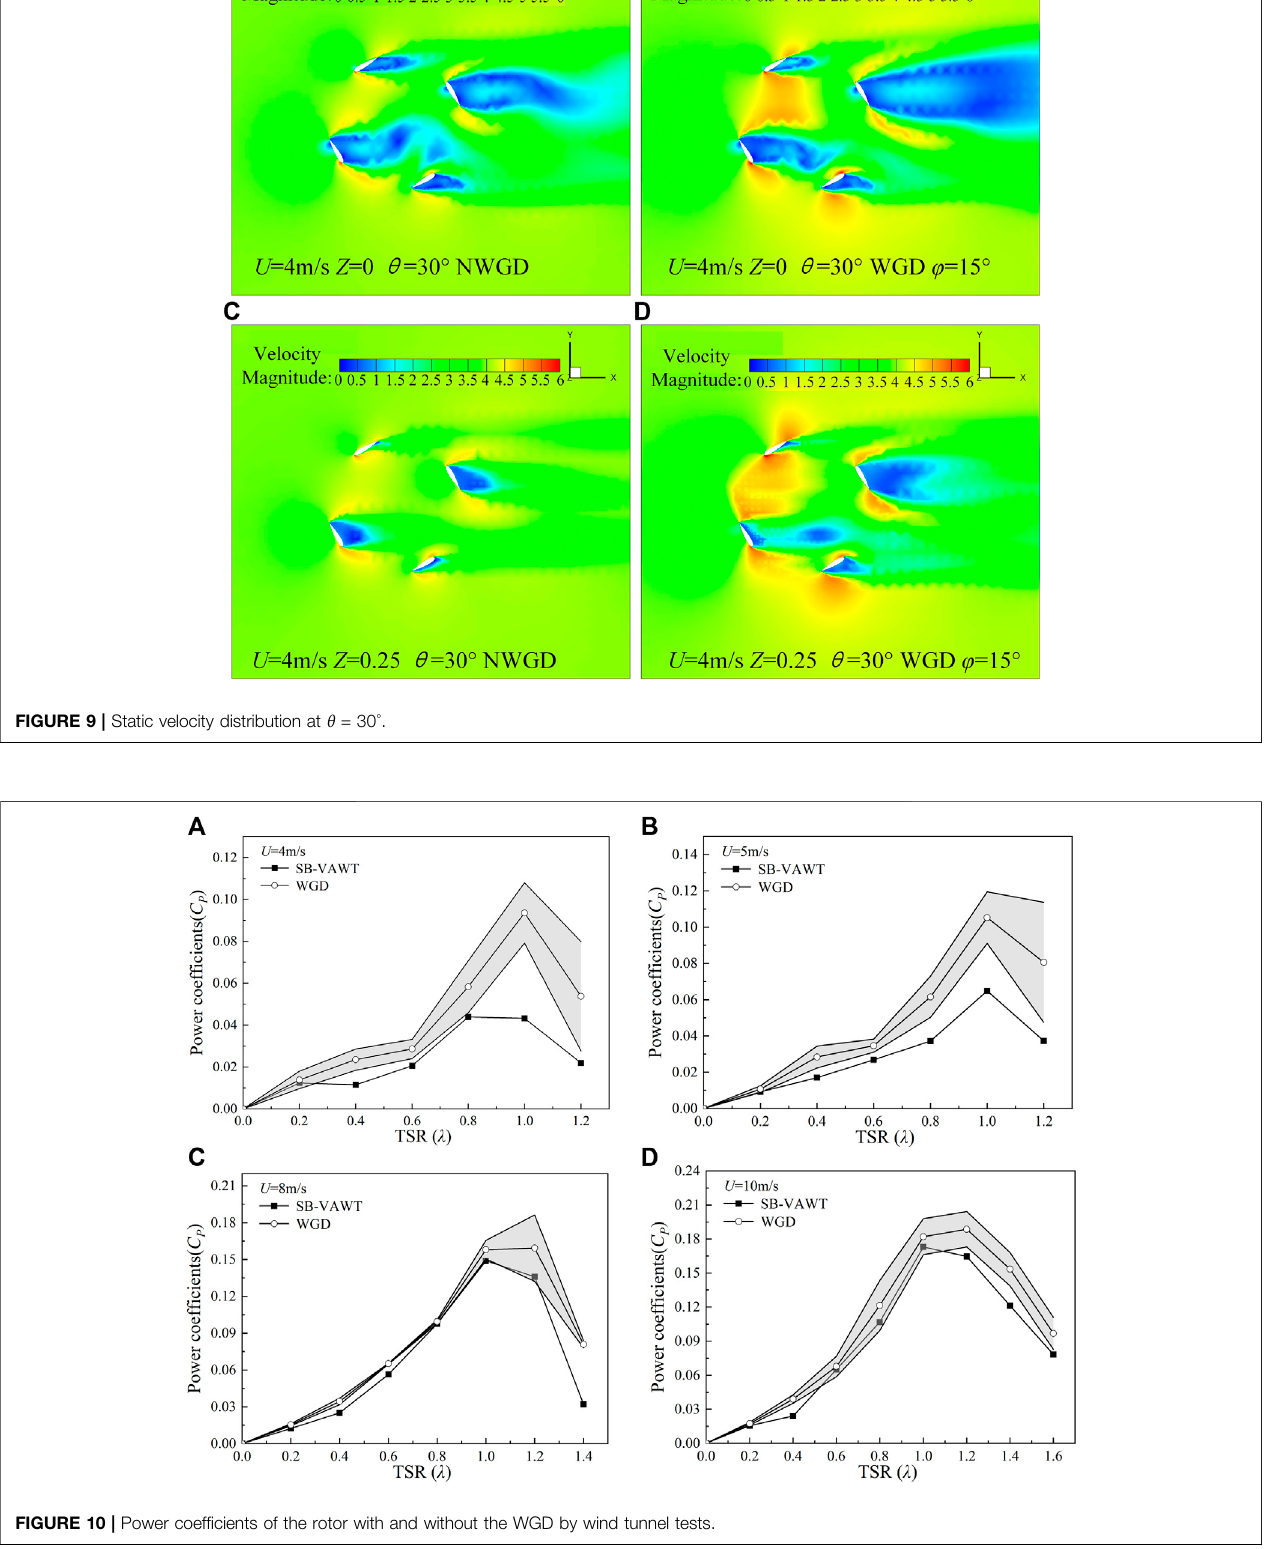
Frontiers in Energy Research |